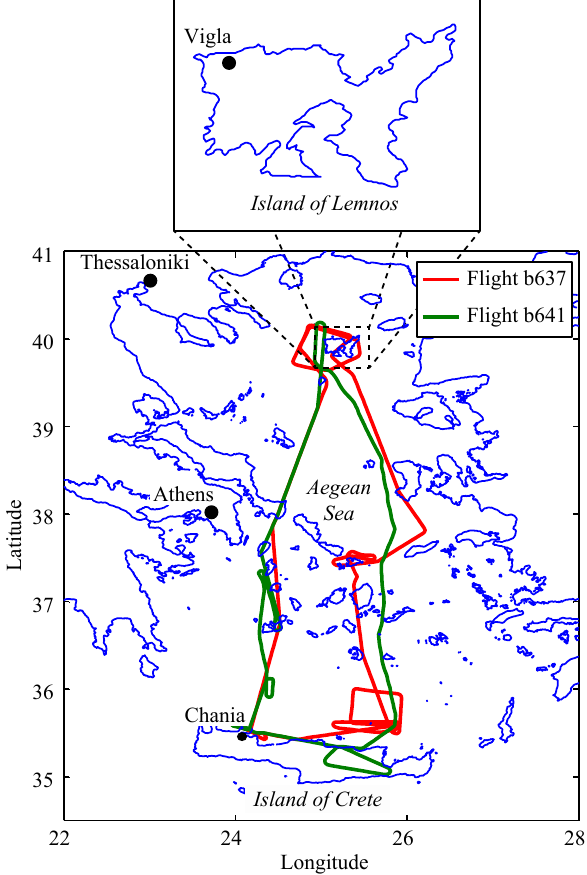
Fig. 1. Map of Greece showing the island of Lemnos and the lo- cation of the ground station at Vigla on the northwestern part of the island. The red and green lines show the paths followed by the FAAM BAe-146 aircraft on flights b637 and b641, performed on 1 and 4 September,